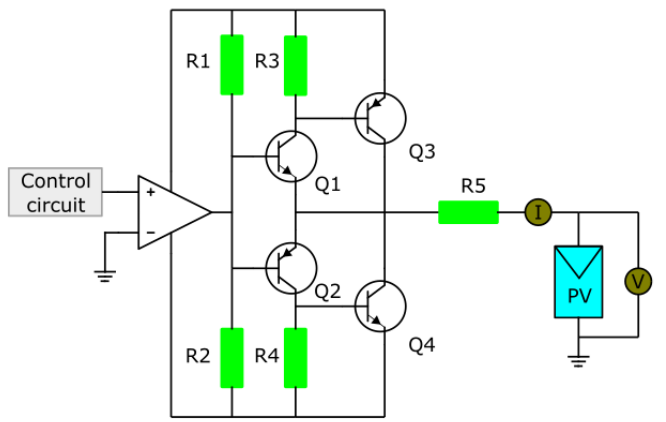
Figure 13. Bipolar Power Amplifier tracer. Source [16], own elaboration.